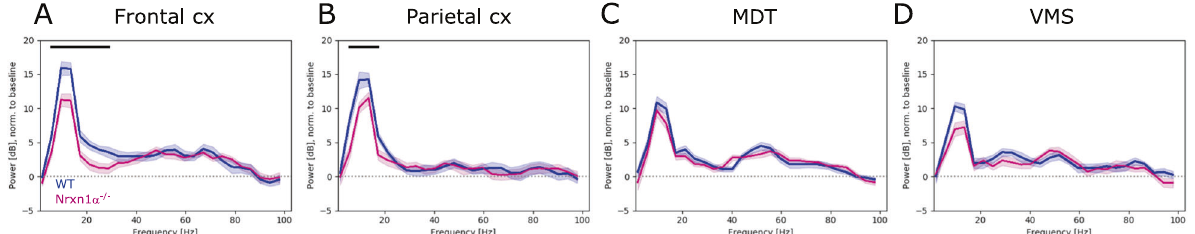
Fig. 3 Power of auditory-evoked brain oscillations. A Spectral power of chirp-evoked oscillations for frontal cortex, B parietal cortex, C mediodorsal thalamus, MDT and D ventromedial striatum, VMS. WT ( N = 14) displayed in blue, Nrxn1 − / − ( N = 14) shown in magenta. Data displayed as mean + SEM and tested with unpaired CBPT. Black bars above the graphs represent clusters with statistically signi fi cant